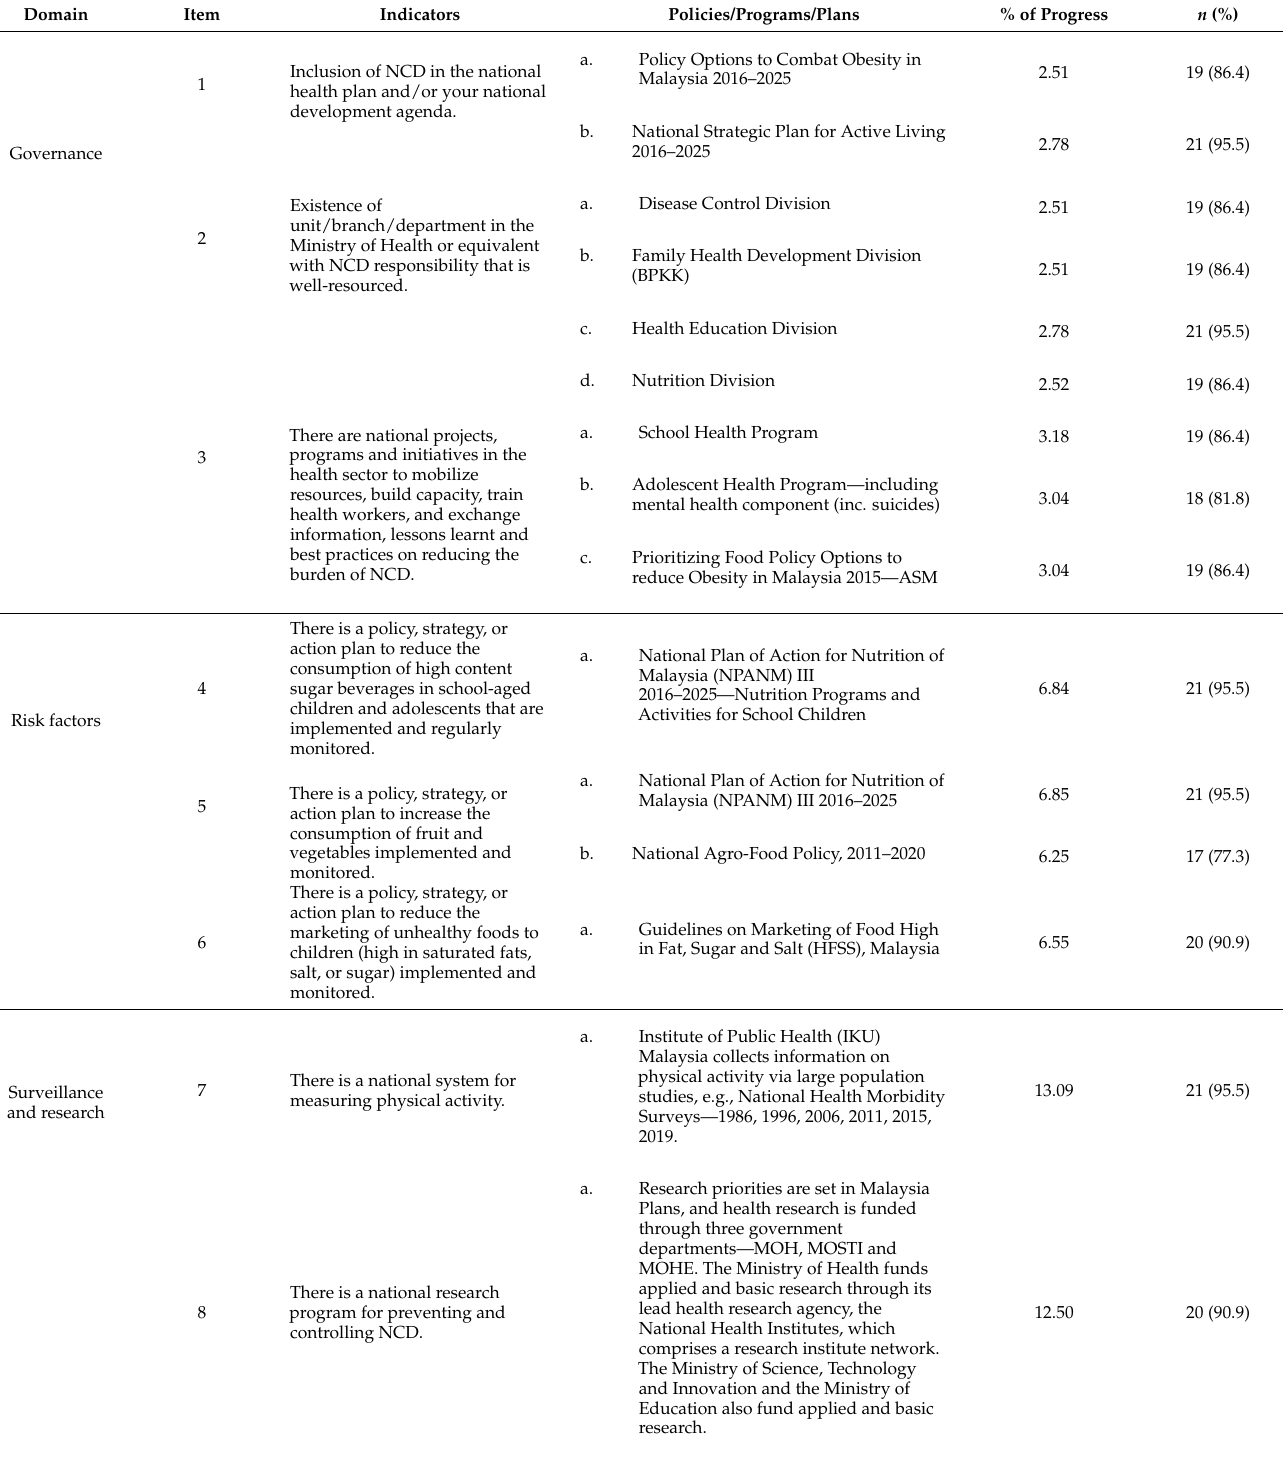
Table 3. Number of respondents and percentage of progress in the various domains and its indicators.